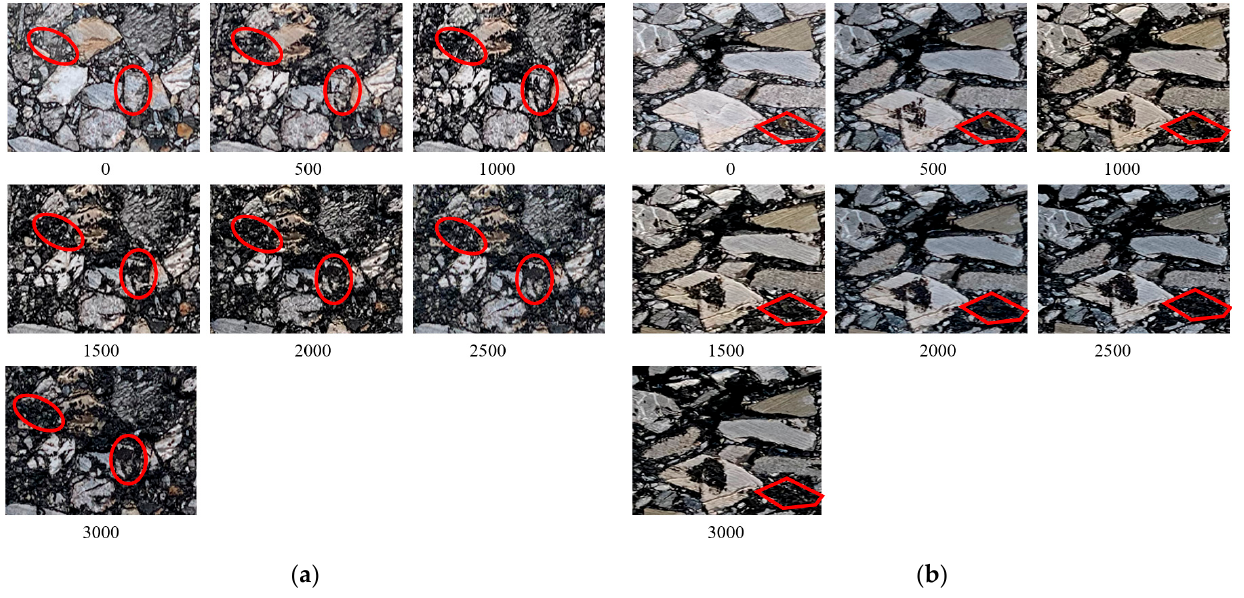
Figure 13. Variation of sectional air void with loading cycles: ( a ) AC-13; ( b )